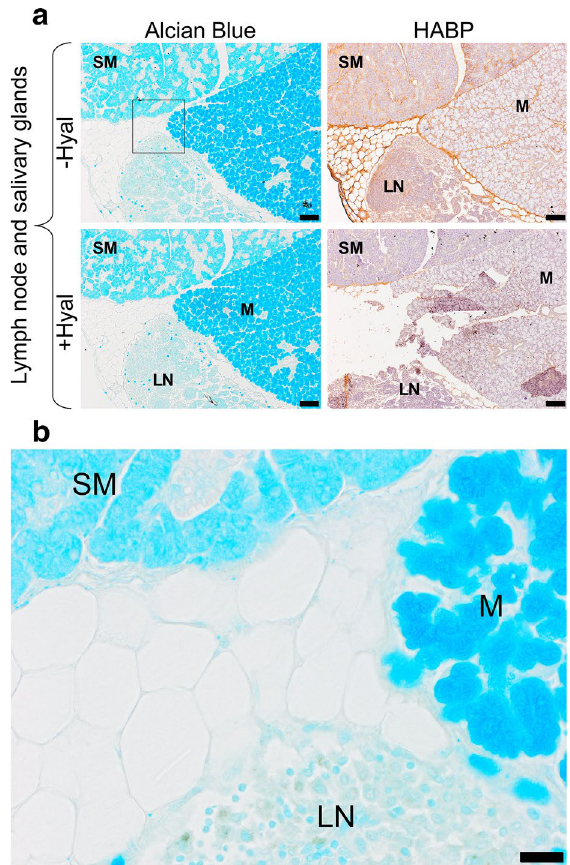
Figure 3. Alcian blue and HA stainings of mouse lymph node and salivary glands. ( a ) Mouse lymph node (LN), and sero-mucosal (SM) and mucosal (M) salivary glands stained with either Alcian Blue or a HA binding protein followed by peroxidase detection, with ( +) or without (−) 3-h incubation with 100 U/ml hyaluronidase from Streptomyces hyalurolyticus . Scale bars, 100 µm. ( b ) Alcian blue staining in mouse LN, and SM and M salivary glands at higher magnification. Scale bars, 20